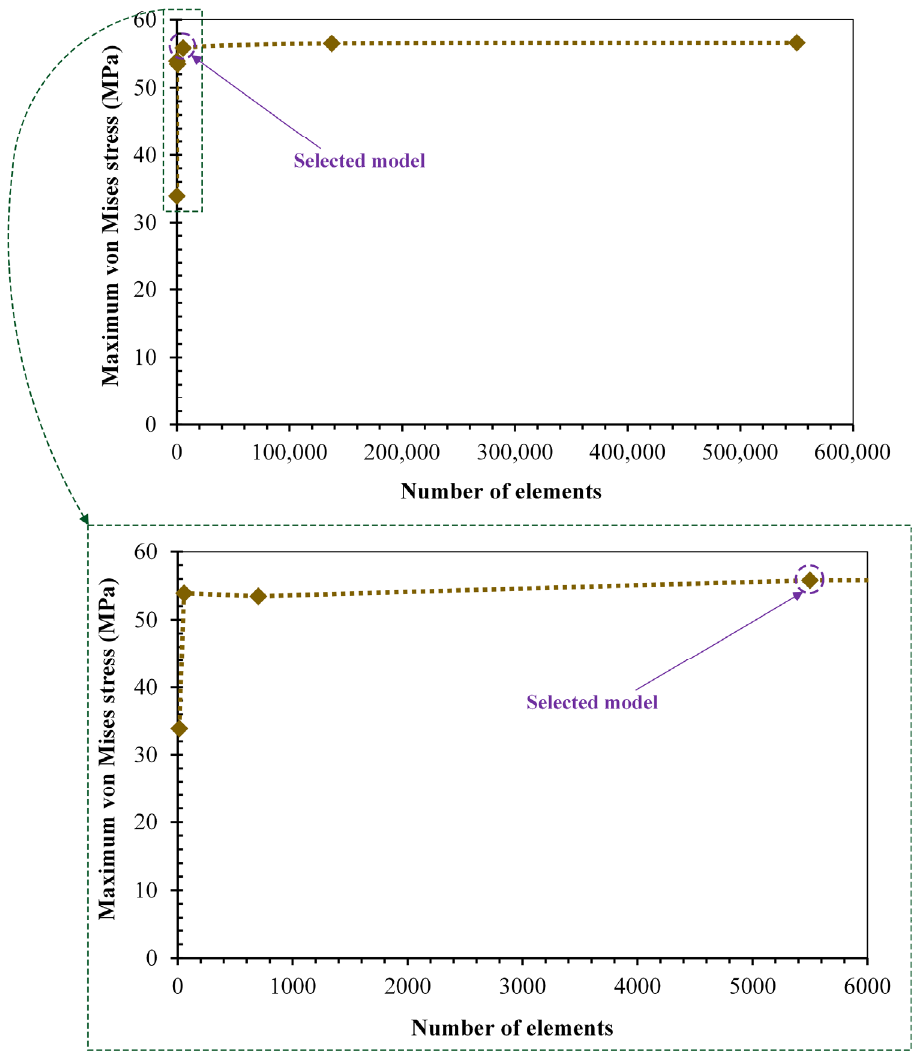
Figure 4. Convergence study of CoCrMo-on-CoCrMo bearing from von Mises stress result.